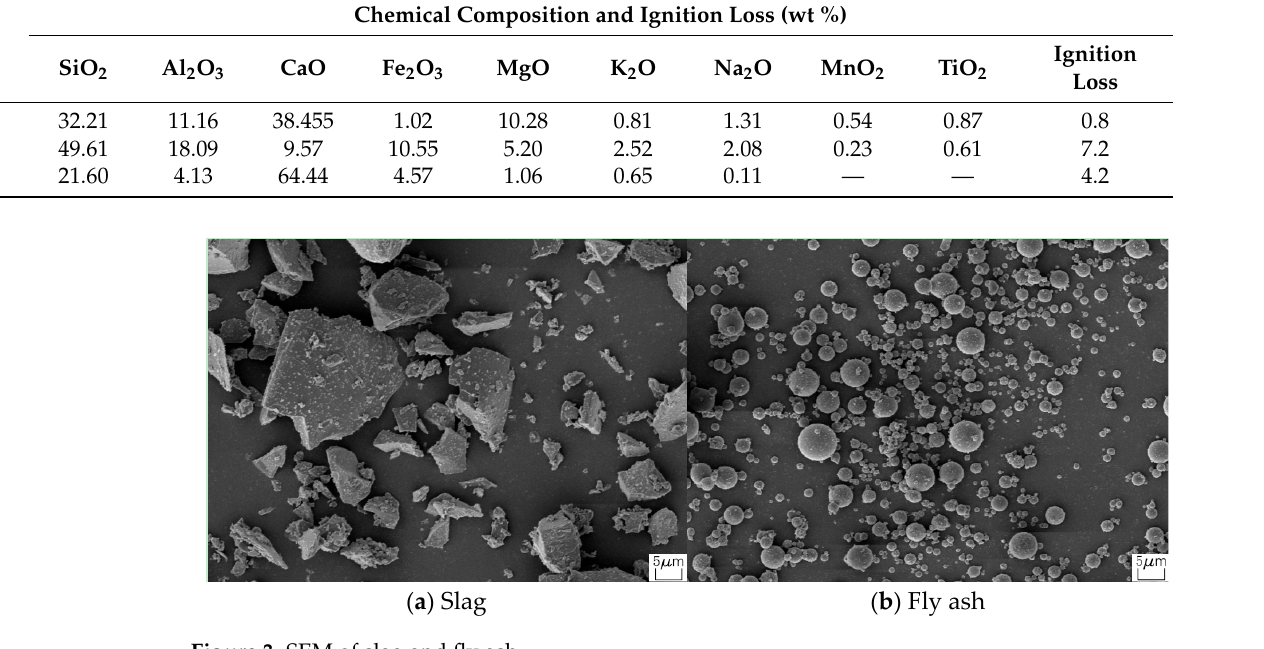
Figure 4. XRD of slag and fly ash. ( a ) Slag; ( b ) Fly ash.